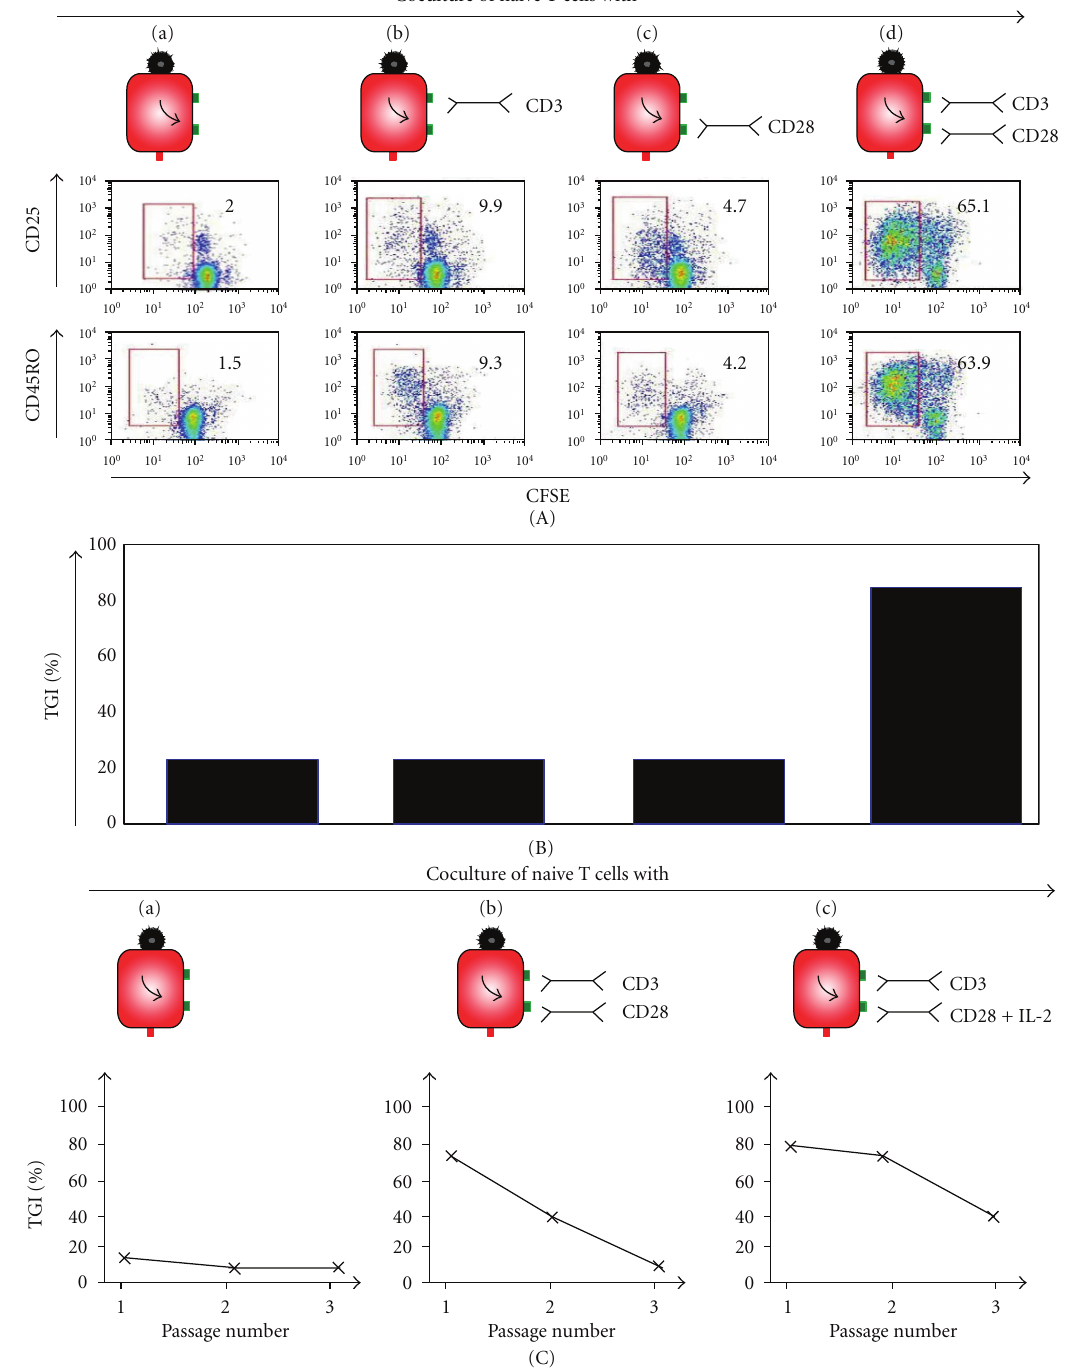
Figure 3: Activation of naive T cells towards tumor cells by the NDV-based tumor vaccine combined with bsAbs in di ff erent combinations.